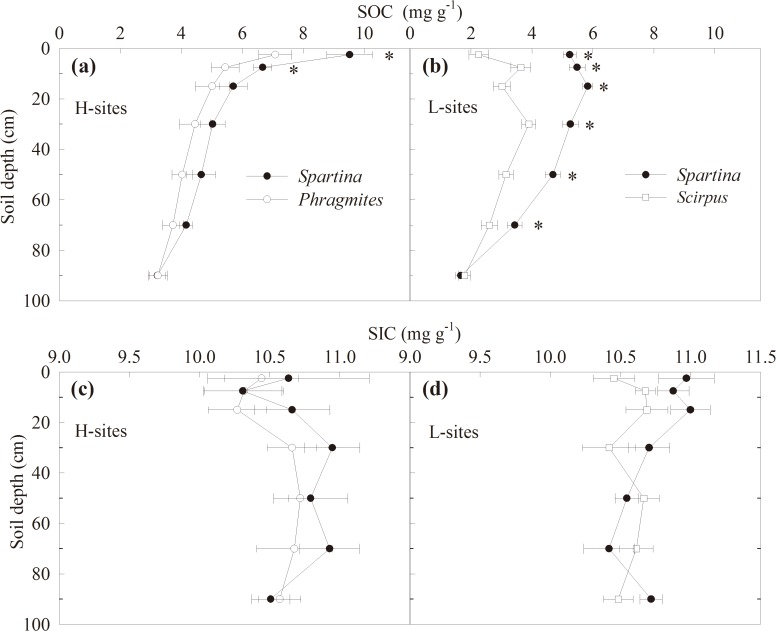
Soil organic and inorganic carbon in different plant stands.Soil organic carbon (SOC) and inorganic carbon (SIC) distribution in soil profiles (0–100 cm deep) in the S. alterniflora (Spartina) and P. australis (Phragmites) stands in the H-sites, and S. alterniflora and S. mariqueter (Scirpus) stands in the L-sites. Bars represent mean ± SE (n = 9), asterisks indicate significant differences (P < 0.05) between means of different stands.